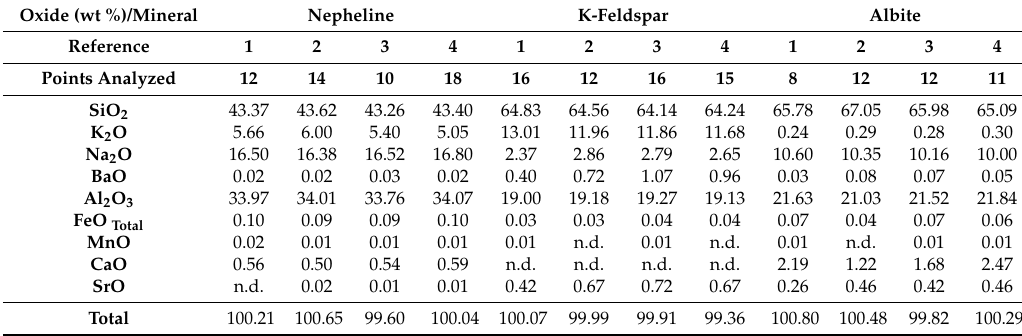
Table 7. Nepheline, K-feldspar and albite average mineral chemistry by georeferenced point in Figure 1. n.d. = not detected.